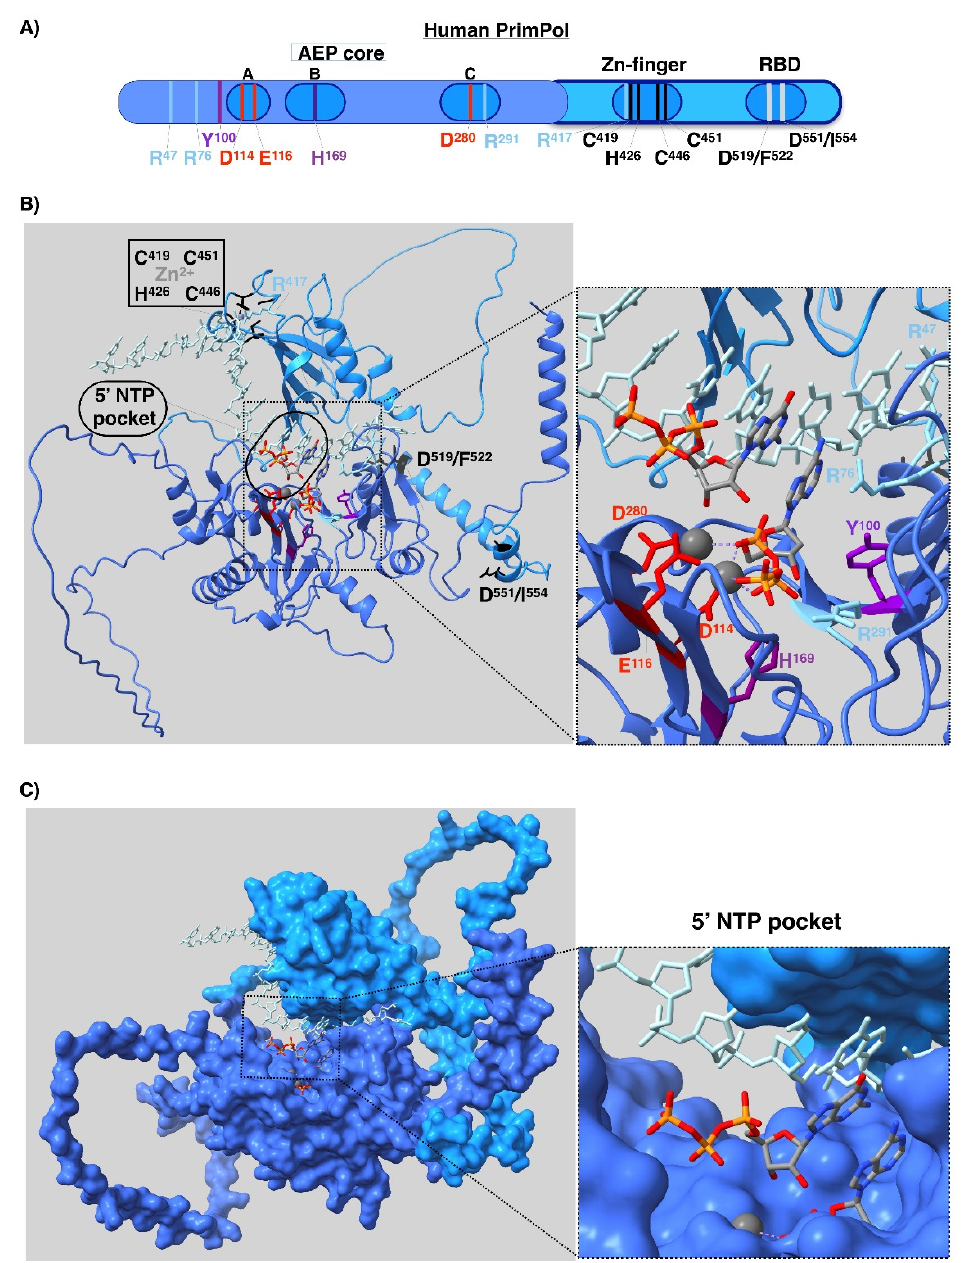
Figure 7. “Structure of human PrimPol. ( A ) Linear representation of the structure. AEP domain is colored in blue and C-terminal region in light blue. In motifs ( A – C ) (which contain the carboxylates used to coordinate the metals and the key histidine to stabilize the incoming nucleotide), the Zn finger and the RPA binding domain (RBD) are highlighted. ( B ) Model structure obtained from AlphaFold v2.0 protein structure database and modeled in complex with DNA template and 3 ′ dNTP by software fitting with PDB ID 7JKP, and 5 ′ NTP by manual fitting with PDB ID: 7JKP. AEP domain is colored in blue and C-terminal region in light blue, which contains the Zn-finger domain and RPA binding sites, which are colored in black. The template is colored in orange, and 5 ′ NTP and 3 ′ dNTP are colored with CPK code. The key residues are shown in sticks: D 114 , E 116 , and D 280 colored in red, H 169 in purple, Y 100 in dark purple, and R 47 , R 76 , R 291 , and R 417 in blue. ( C ) Surface representation of the PrimPol structure model showing in detail the 5 ′ NTP pocket.”.